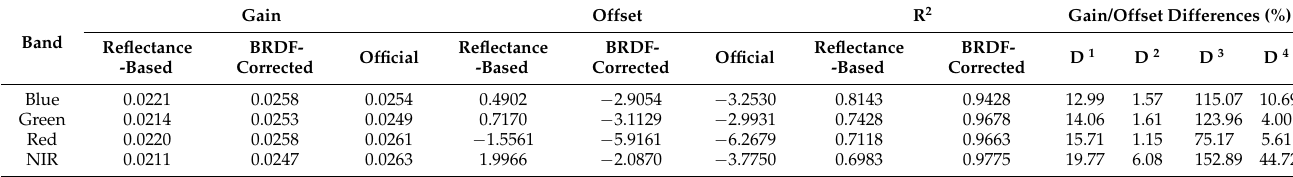
Table 1. The three versions of calibration coefficients for FengYun-3D MEdium Resolution Spectrum Imager-II (FY-3D MERSI-II) were derived using different methods, including the officially provided coefficients. The differences between the three versions of coefficients are also provided in the table. The shaded columns are the calibration coefficients and determination coefficients derived using the proposed method (BRDF-corrected) in this